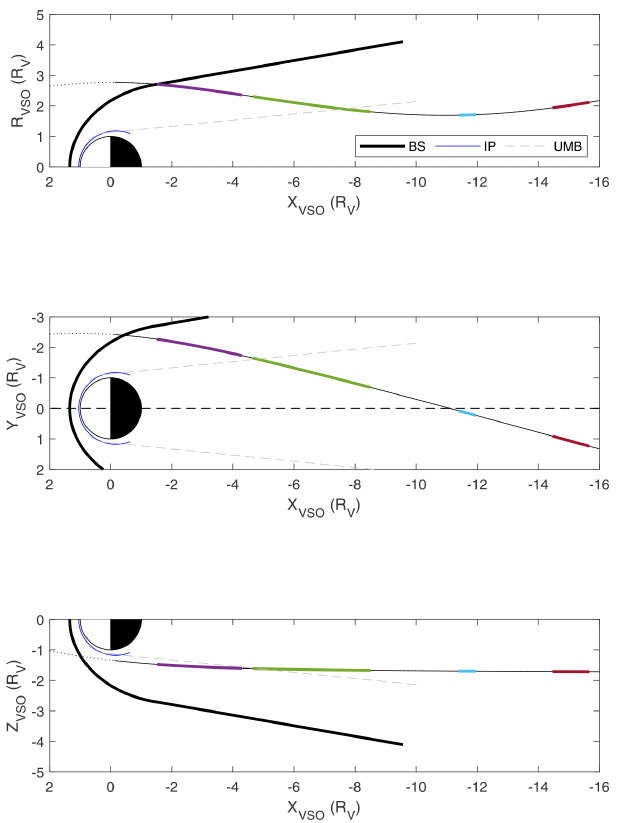
Figure 2. Full 1s resolution MPO-MAG data. Top to bottom panels Figure 1. The BepiColombo first flyby to Venus in VSO coordinates show the B x ,B y ,B z and the absolute magnetic ( B m ) field compo- (cid:113) + Z 2 Y 2 (with R VSO = ). The thick black line is the bow nents, respectively. The vertical purple line marks the bow shock VSO VSO shock (BS) for solar minimum conditions (Zhang et al., 2008b), transit. The purple, green, blue, and red marked intervals are of spe- the thin blue line is the ionopause (IP) (Zhang et al., 2008b), and cial interest as in Fig. 1 and listed in Table the grey dashed lines are the upper mantle boundary (UMB) (Mar- tinecz et al., 2009b). The thin black (dotted) line is the trajectory of BepiColombo, with the solid line showing the interval discussed in this paper. The purple, green, blue, and red marked intervals are of special interest listed in Table 1.